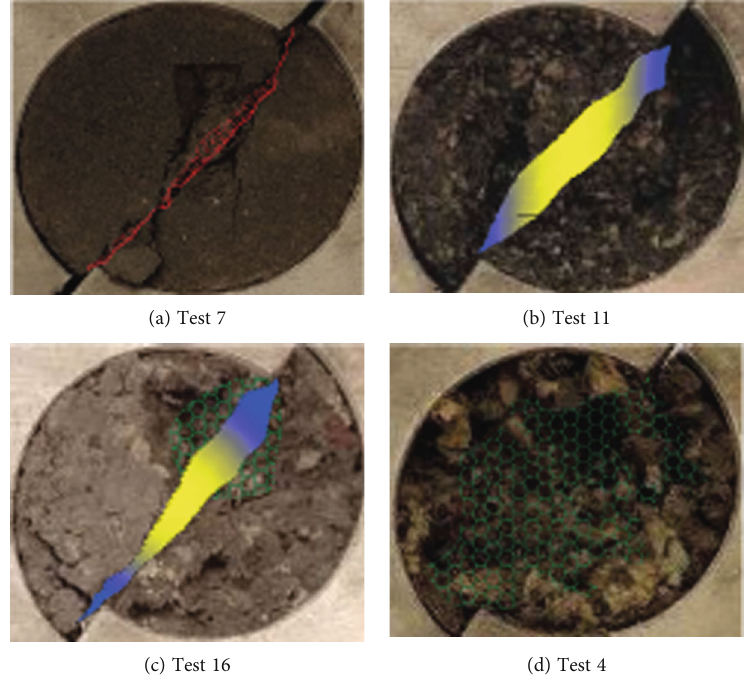
Figure 9: Shear failure characteristics of the consolidated